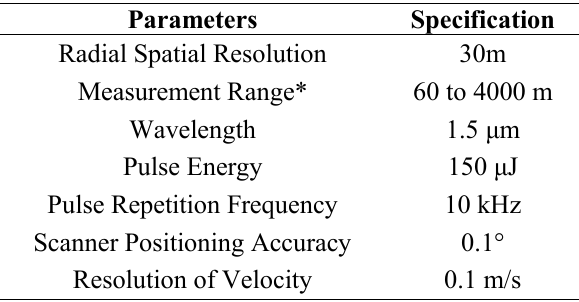
Fig.2. Wind Shear statistics reported by the pilots in different runways at BCIA (from 2015, 2016 and 2018).